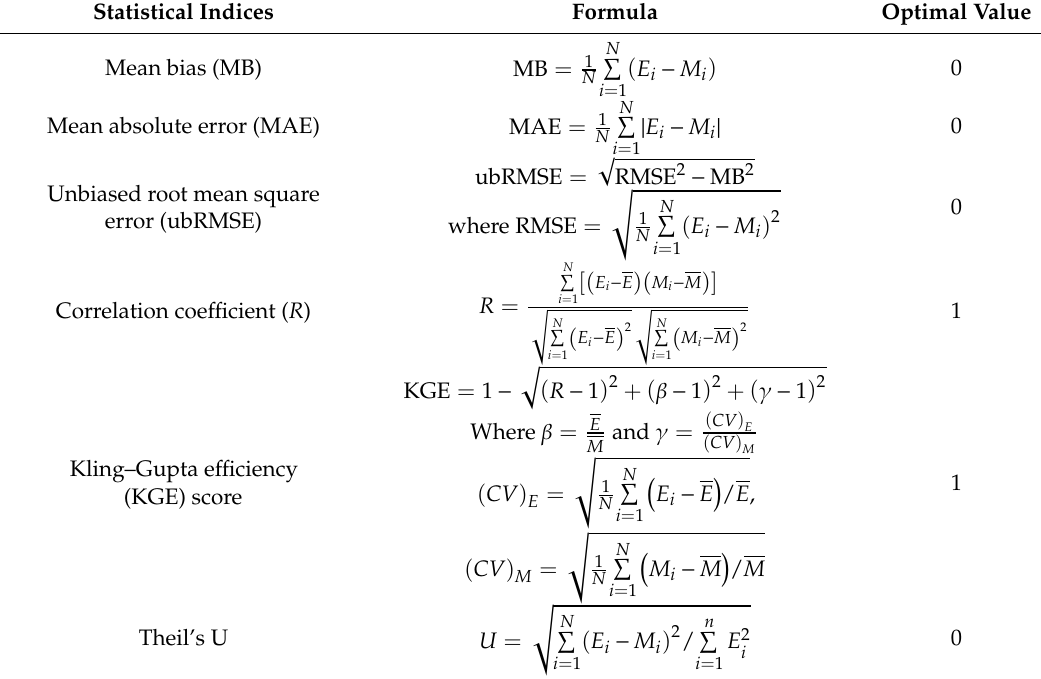
Table 2. Statistical indices used to assess the performance of the dynamic regional blended precipitation estimated using WALS-RBPD, M i depicts the measured (RGs) precipitation data, E i and M i denotes the mean estimated and measured precipitation, and N represents the number of data pairs. Moreover, ffi cient of variation of estimated and measured ( CV ) ( CV ) M denotes the coe E and